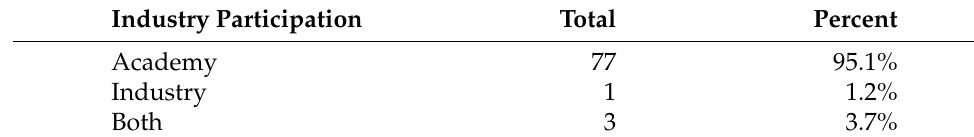
Figure 8. Conferences by country. Table 8. Industry participation.